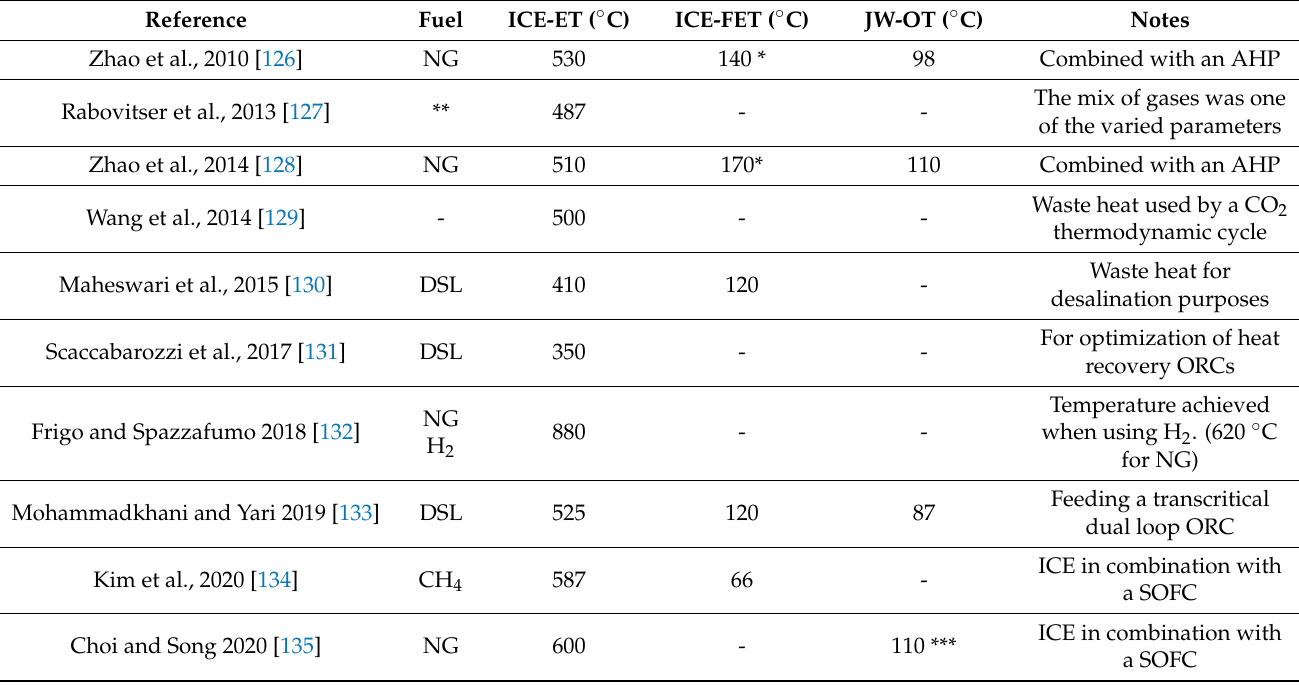
Table 11. Literature review of the values for Internal Combustion Engine selected parameters.